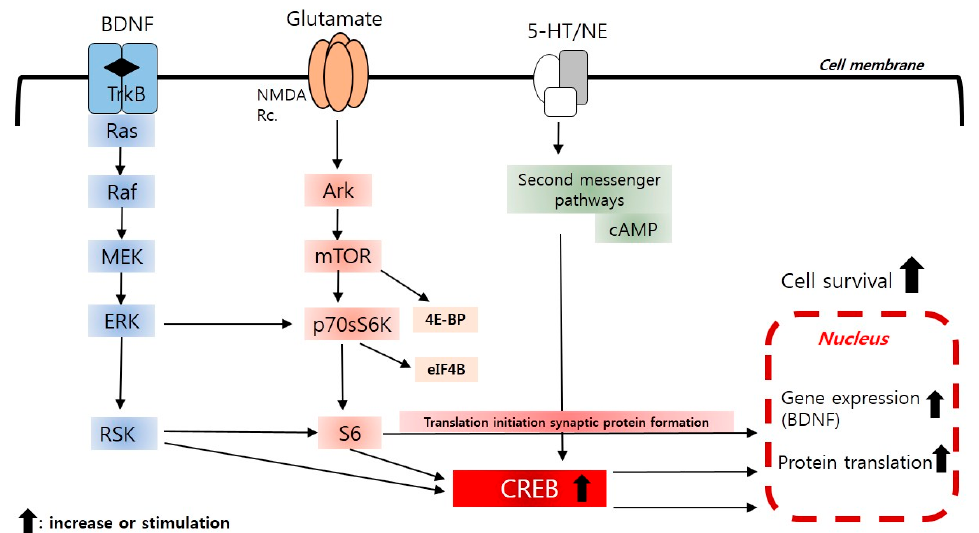
Figure 2. Neurotrophic factor (mitogen activated protein (MAP) kinase cascades; e.g., brain-derived neurotrophic factor (BDNF)) and protein translation signal pathways (protein translation signaling (mTOR); glutamate).